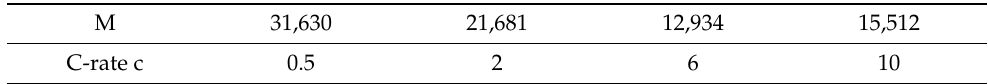
Table 2. M ( c ) and C-rate